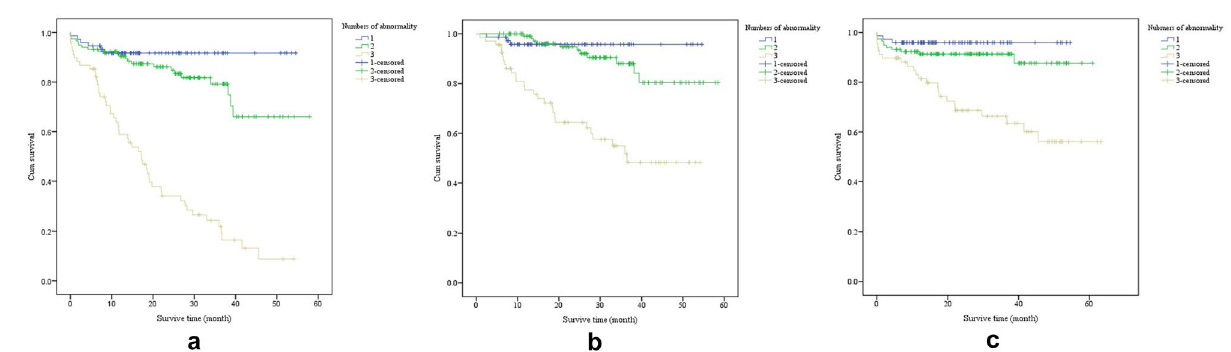
Figure 1. Kaplan–Meier survival curves for ( a ) total adverse event, ( b ) recurrence, and ( c ) all-cause mortality in acute pulmonary embolism patients categorized by number of abnormalities (log rank test p < 0.001 for